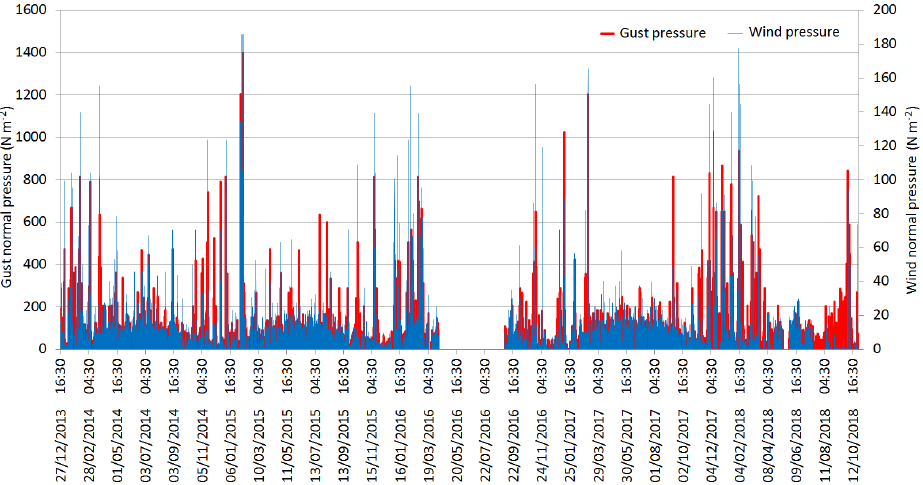
Figure 19. Wind and gust normal pressure time series data showing daily, seasonal and annual variation patterns at the Denza station during 2014–2018.